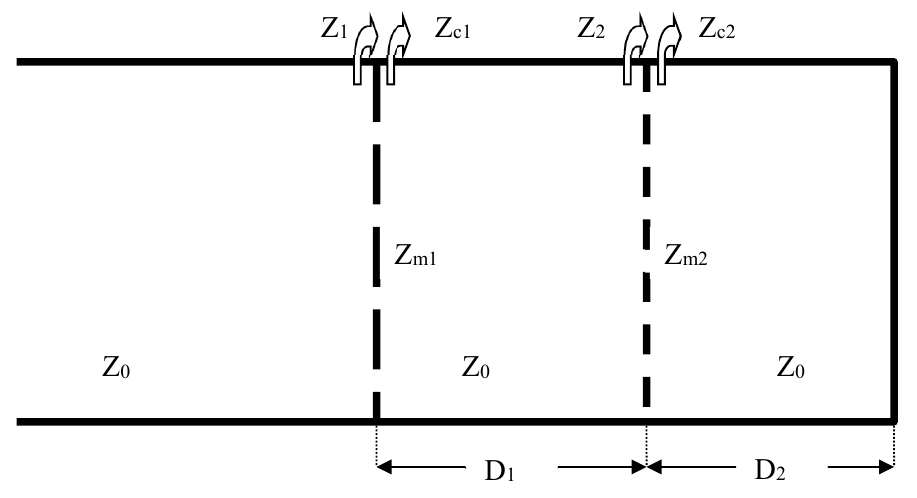
Figure 23. Normal incidence absorption coefficient of an SL-MPP with d = 0.12 mm, t = 1 mm, φ  = 10%, and D = 2 cm.